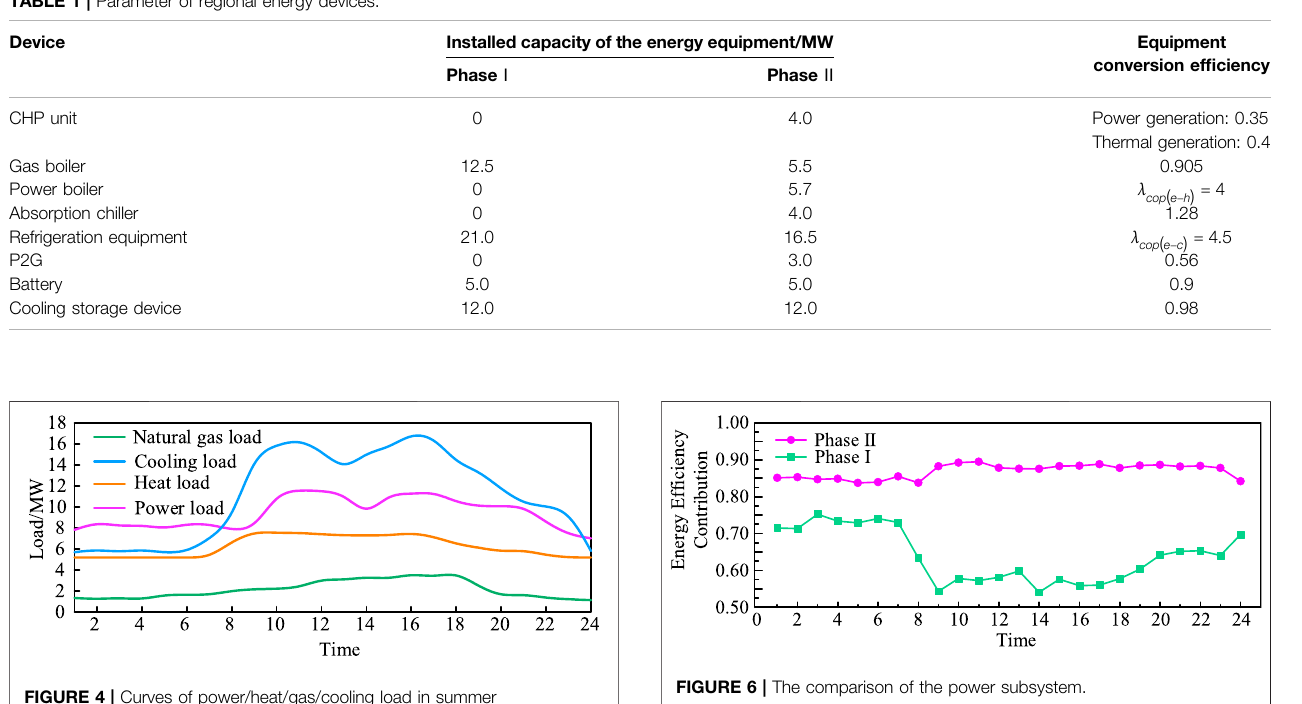
TABLE 1 | Parameter of regional energy devices.